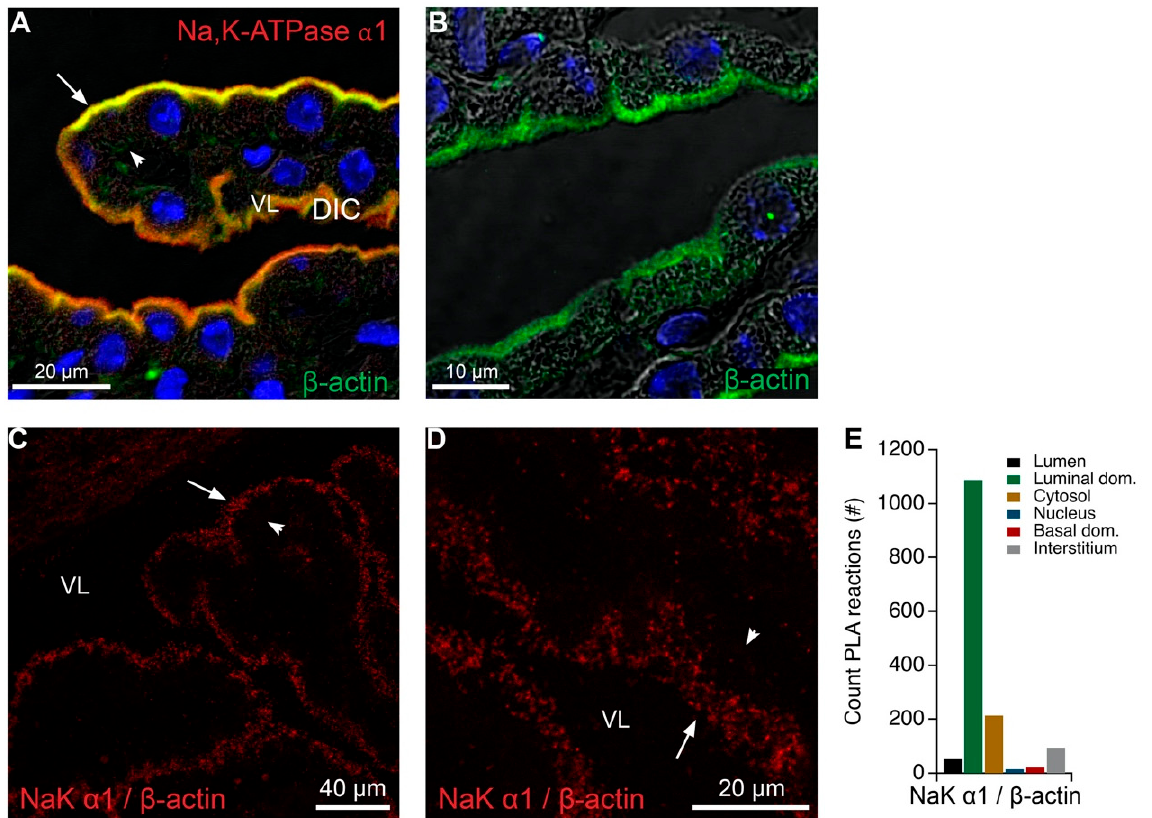
Figure 5. Colocalization of Na,K-ATPase α 1 and β -actin in the CP. ( A ) Double immunofluorescence labeling for Na,K- ATPase α 1 (red) and β -actin (green) in the CPE. ( B ) Similar labeling for β -actin overlaid on the corresponding DIC image. ( C ) Representative immunofluorescence image of PLA products (red) using anti- β -actin ( β -actin) and anti-Na,K-ATPase α 1 (NaK α 1) antibodies and cell nucleus counterstain (blue) overlaid on the corresponding DIC image. ( D ) Similar micrograph of the same structure at higher magnification. Arrows indicate luminal surfaces, while arrowheads mark basolateral surfaces. VL denotes the fourth ventricle lumen. ( E ) Bar graph representing the count of PLA reactions in the indicated image areas.